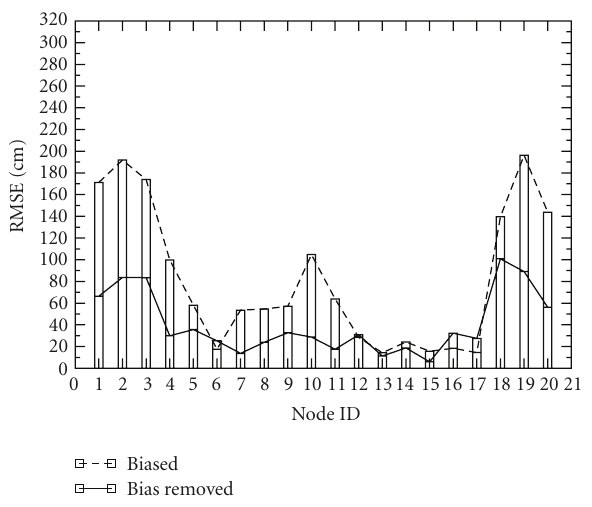
Figure 7: RMSE as a function of target position in the absence and presence of priori information (i.e., with the bias and after removing the bias), using the best selection for reference beacon. N = 5 beacons are considered.